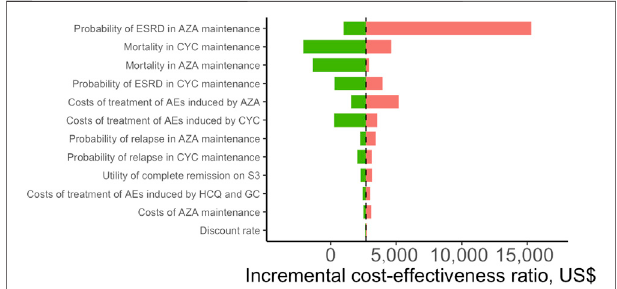
FIGURE 2 | Tornado plot of deterministic sensitivity analysis for patients withlupusnephritisreceivingthemostcost-effectivestrategy(S3:CYC → AZA) compared with the baseline strategy (S1: CYC → CYC) over a lifetime horizon. The base-case result is presented by vertical dashed line. The length of the bars re fl ects the degree of parameters that in fl uence quality-adjusted life years. Only the top 12 most in fl uential parameters were presented. HCQ, hydroxychloroquine; GC, glucocorticoids; CYC, cyclophosphamide; AZA, azathioprine; ESRD, end-stage renal disease; AEs, adverse